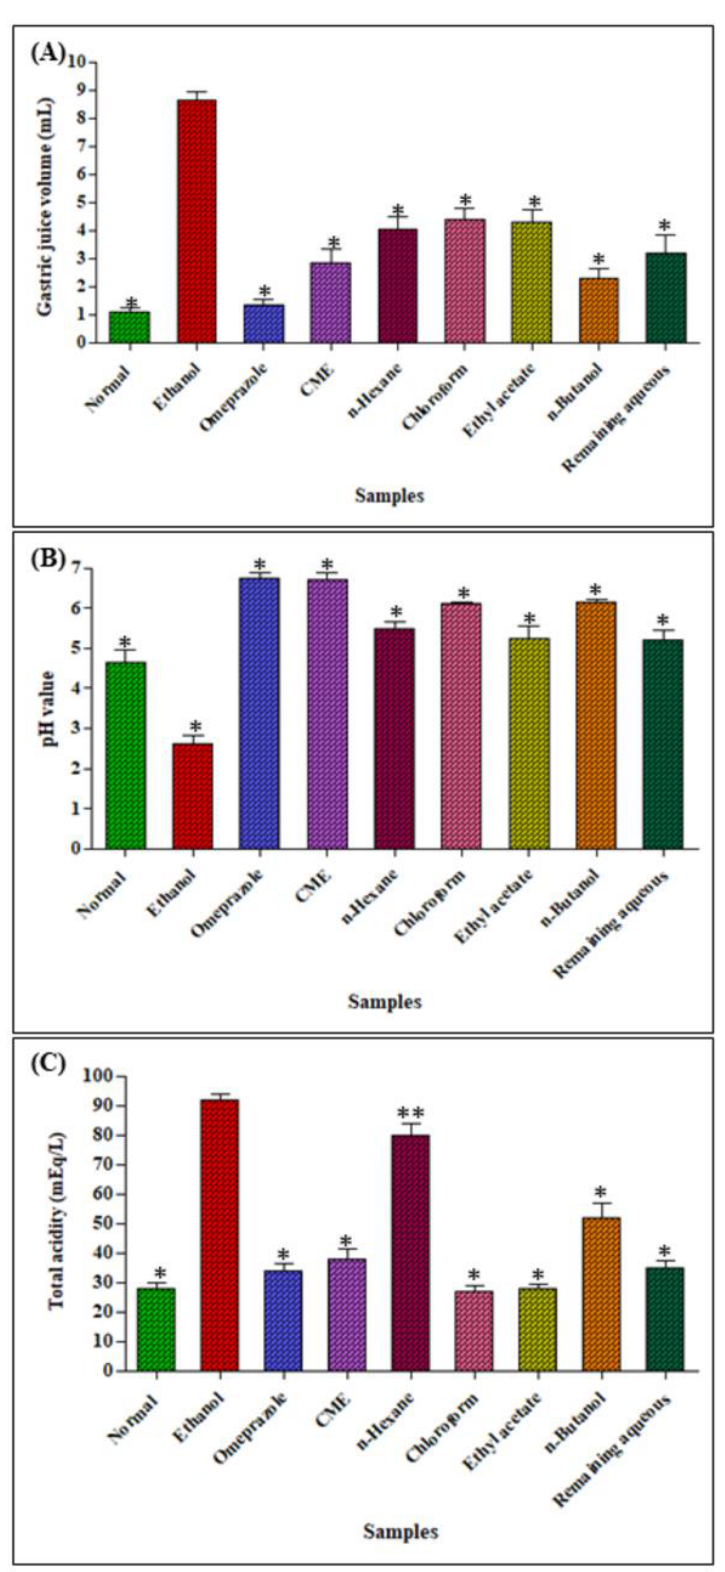
Figure 3. Effect of H. crispum total methanol extract (CME) as well as its various fractions on gastric juice volume ( A ), pH ( B ) and total acidity ( C ) in ethanol induced acute ulcer; the results are expressed in the form of Mean ± SEM. Significant at p < 0.01 * and 0.5 ** from the diseased control